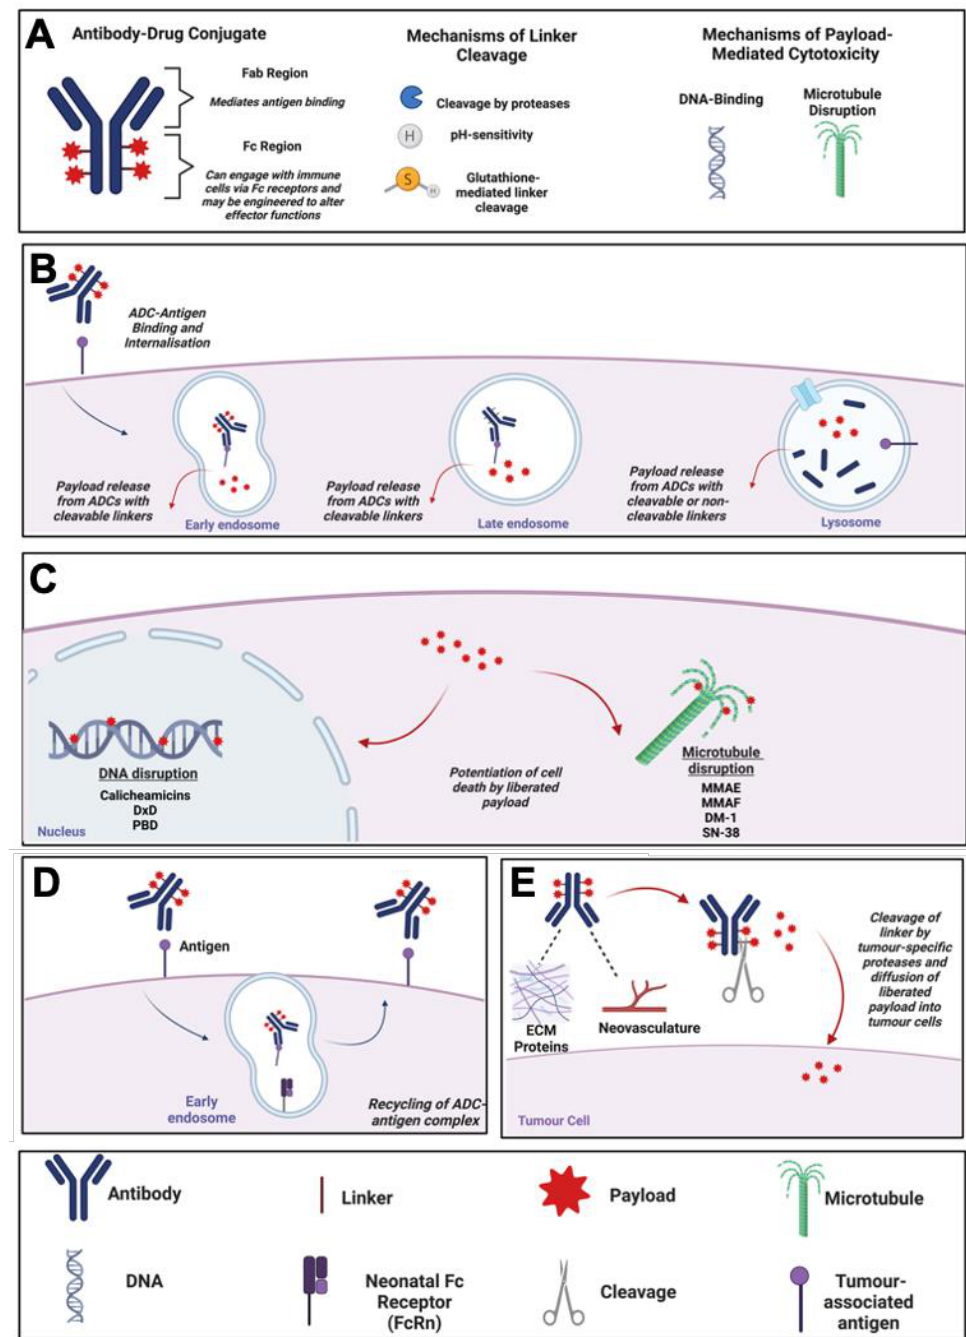
Figure 1. ADC Mechanism of Action. ( A ) Schematic diagram of an ADC, and descriptions of mechanisms of linker cleavage and payload toxicity. ( B ) Mechanism of action of an internalising ADC: Internalisation of ADC, trafficking to early and late endosomes and lysosomes followed by release of payload. ( C ) Mechanisms of cell death potentiated by ADC payloads, and relevant examples. ( D ) Schematic diagram of ADC recycling mediated by the neonatal Fc receptor (FcRn). ( E ) Mechanism of action of a non-internalising ADC. ADC binding to tumour-proximal extracellular matrix proteins or neovasculature before linker cleavage by proteases and release of cytotoxic payload. Created using Biorender.com. Abbreviations: ADC, Antibody-Drug Conjugate; DM-1, Mertansine DM-1; Dxd, Deruxtecan; ECM, Extracellular Matrix; FcRn, Neonatal Fc Receptor; MMAE/F, Monomethyl Auristatin E/F; PBD,